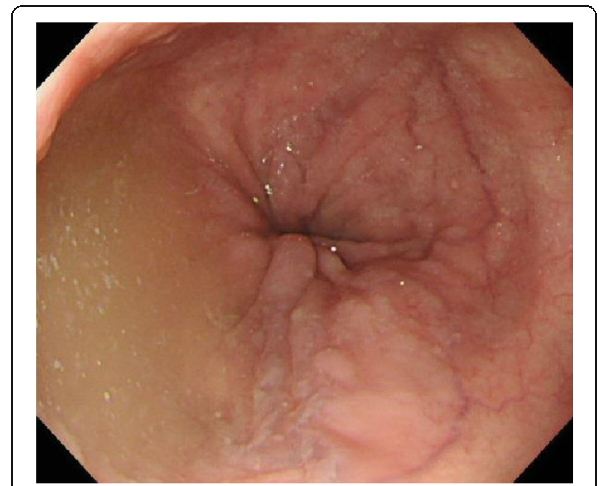
Fig. 7 The maximum transverse diameter of the esophagus by esophagography was found to be 63 mm and was classified as the Fig. 8 The esophageal lumen was distended, in which accumulation